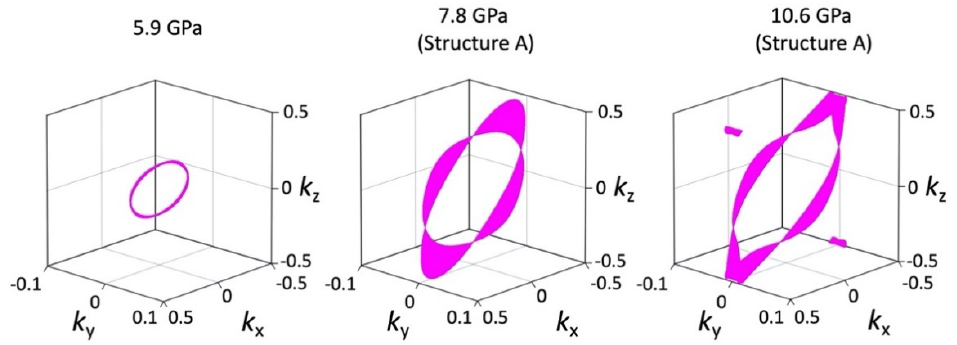
Figure 8. Fermi surfaces in [Pd(dddt) 2 ] at 5.9 GPa, 7.8 GPa and 10.6 GPa.